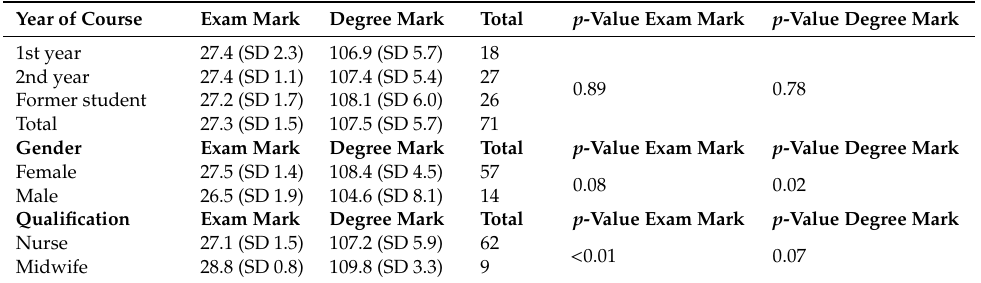
Table 4. Mean, standard deviation and p -value (Student’s t -test and ANOVA) of sample’s exam and degree marks, stratified by year of course, gender and professional